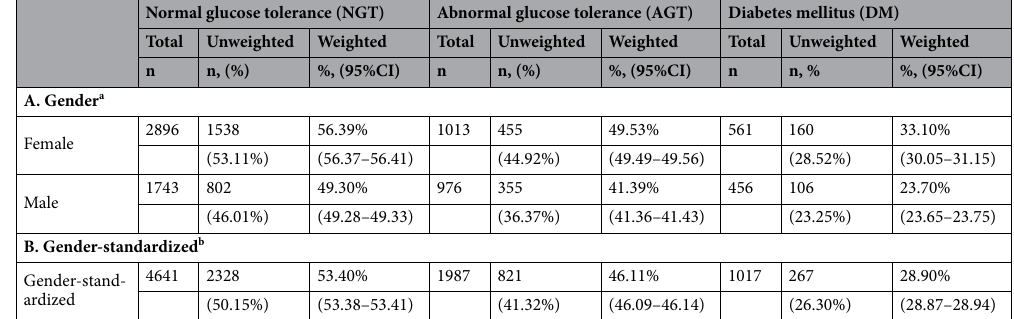
Table 3. The influence of gender on seropositivity rates (%, with 95% confidence intervals [CI]) after hepatitis B vaccination, separated by glucose tolerance state. a P < 0.0001 for the weighted percent between both genders in all three states of glucose tolerance states and for weighted percent among three states of glucose tolerance in both genders. b P < 0.0001 for weighted percent among three states of glucose